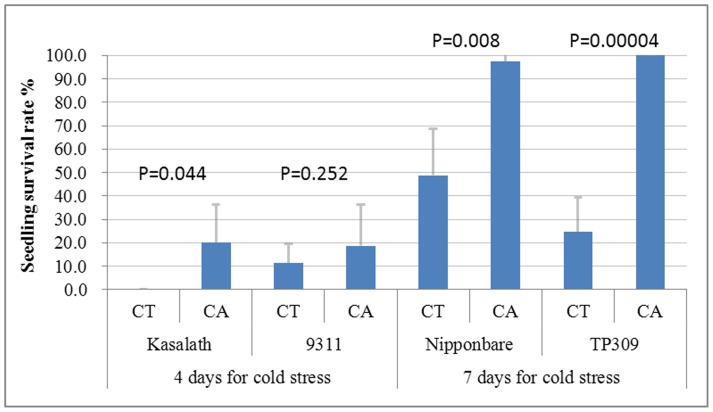
Survival rate of 7-day-old rice seedlings after the low temperature stress with or without chilling acclimation.Cold treatment (CT): 7-day-old seedlings were first maintained for 4 days (for indica rice: 9311 and Kasalath) or 7 days (for japonica rice: Nipponbare and TP309) at a low temperature of 4°C, then restored for 10 days to normal growth temperature. Chilling acclimation treatment (CA): 7-day-old seedlings were first maintained for 2 days at a mild temperature of 12°C, then 4 days (for indica rice: 9311 and Kasalath) or 7 days (for japonica rice: Nipponbare and TP309) at a low temperature of 4°C, and finally restored for 10 days to normal growth temperature. Each rice varieties were treated with four times of independent experiments and the bars represent the standard deviation. P values of T-test for difference between CT and CA treatments of each variety were shown in Fig. 1.